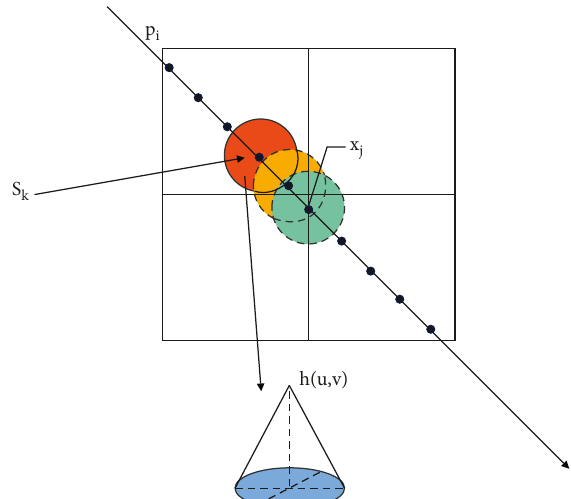
Figure 6: Schematic diagram of the calculation of the sampling value s ik at the point ( X ( s ik ) , Y ( s ik ))